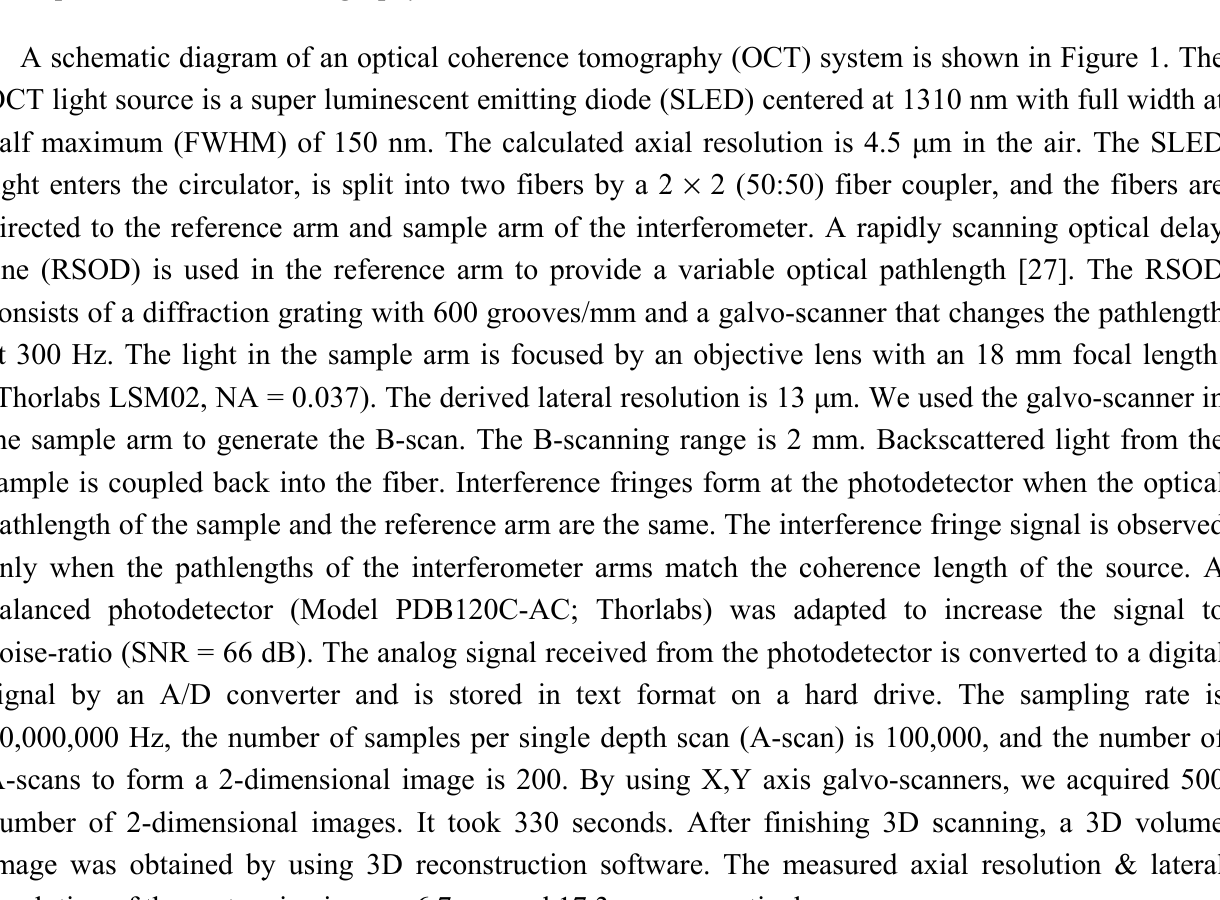
Figure 1. Th full width r. The SLE the fibers